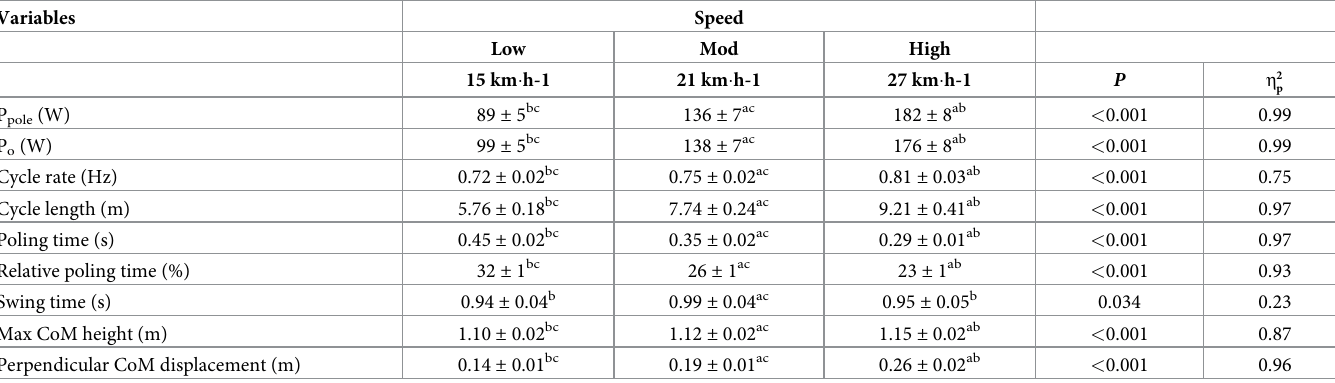
for the repeated measures ANOVA [N = 14]. a, b, and c indicate significant differences from low, moderate, and high speeds, Values are mean ± 95% CI, P -values and η 2 p respectively ( P <